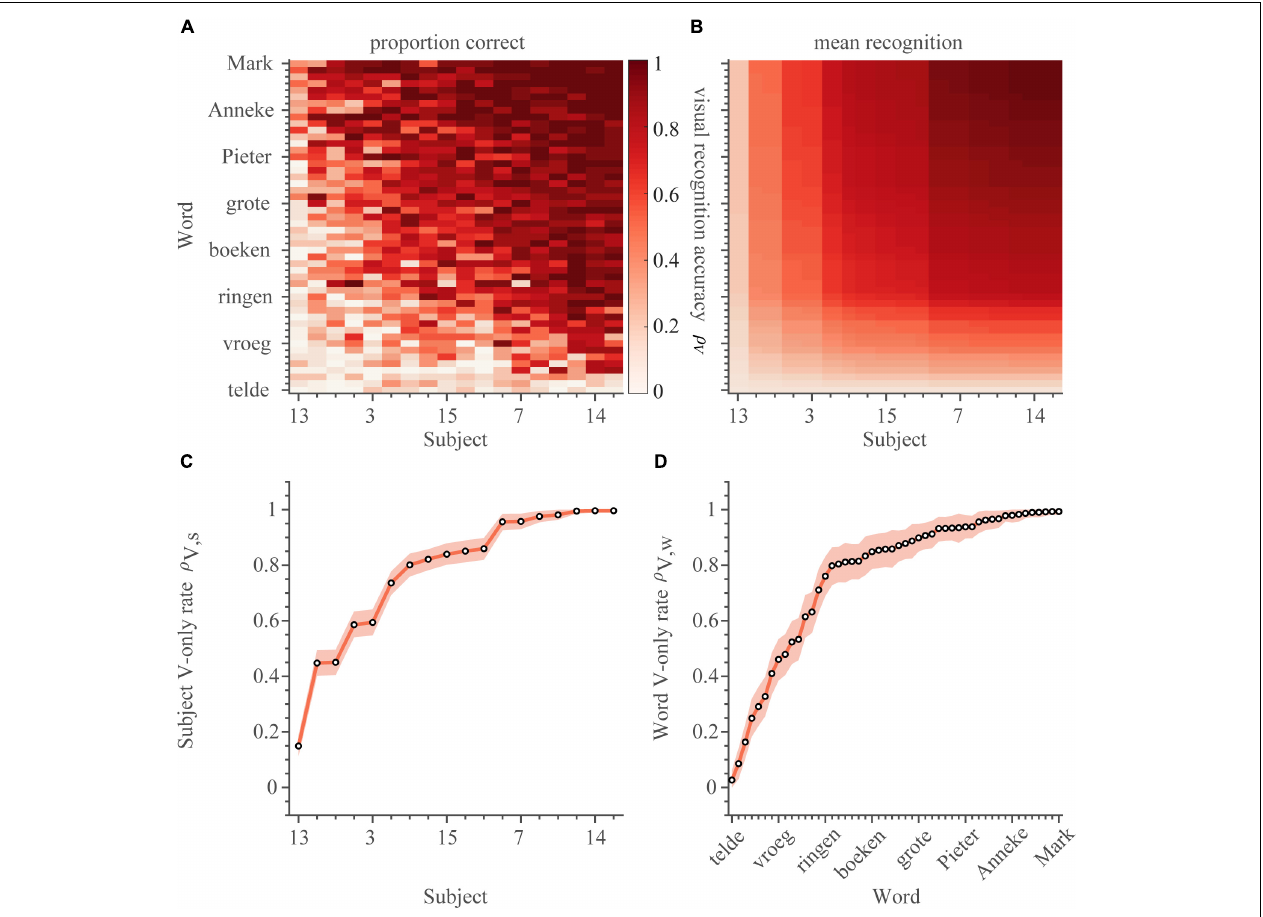
FIGURE 2 | Lipreading. (A) Visual recognition scores. The correct score (number of correct responses divided by the number of presentations) is shown separately for every word and subject (900 entries) for the V-only condition. The correct scores and rates have been ordered by the recognition rates of subjects on the abscissa, and of words on the ordinate from low-left to high-right. (B) The average estimated visual recognition rates (Equation 1). Same layout as in (A) . V-only speech recognition rates for (C) subjects and (D) words. Rates were ordered from low-left to high-right. Open circles indicate the mean of the estimated rate, colored patch indicates the 95% Highest Density Interval (HDI). Reddish colors denote visual